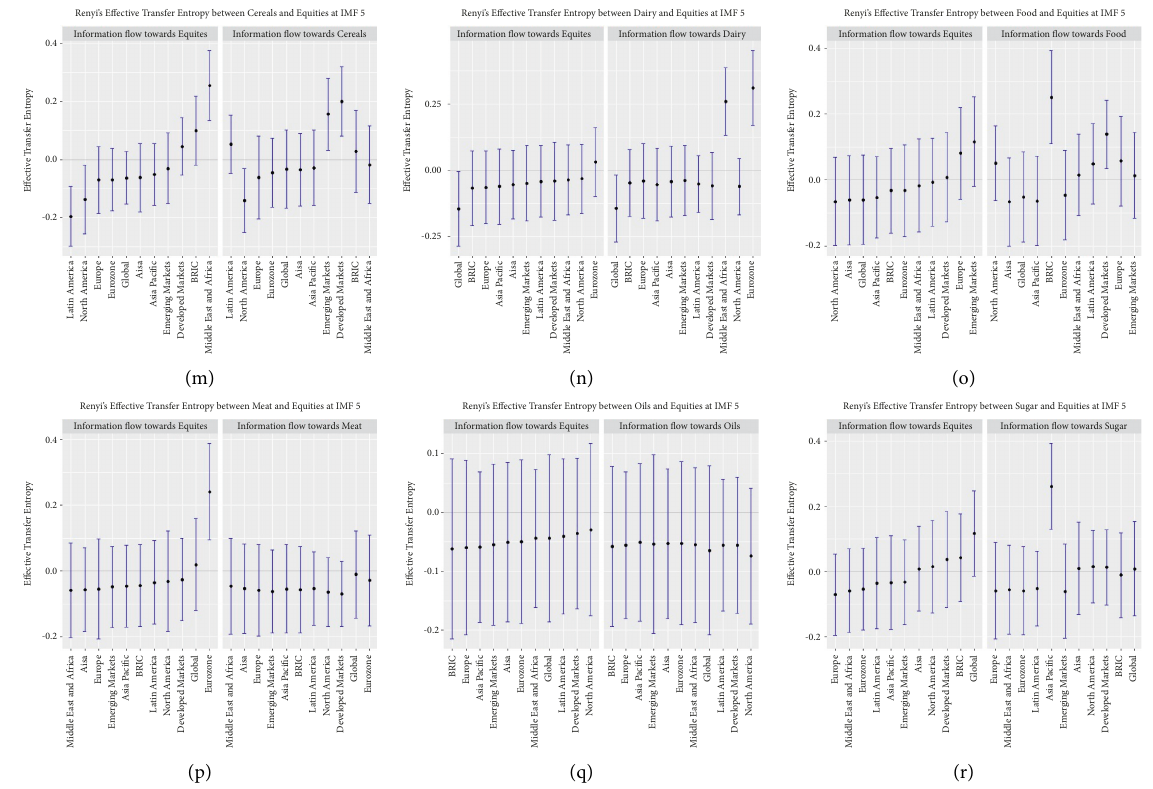
Figure 5: Transfer entropies in the mid-term. Notes: This figure presents the quantified information flow between the returns on world food commodity and regional equity markets at medium-term scales (IMFs 3–5). (a) to (f), respectively, represent ETEs for cereals, dairy, food, meat, vegetable oil, and sugar indices against the regional equities for IMF3 with their corresponding IMF4 and IMF5 being (g) to (l) and (m) to (r).